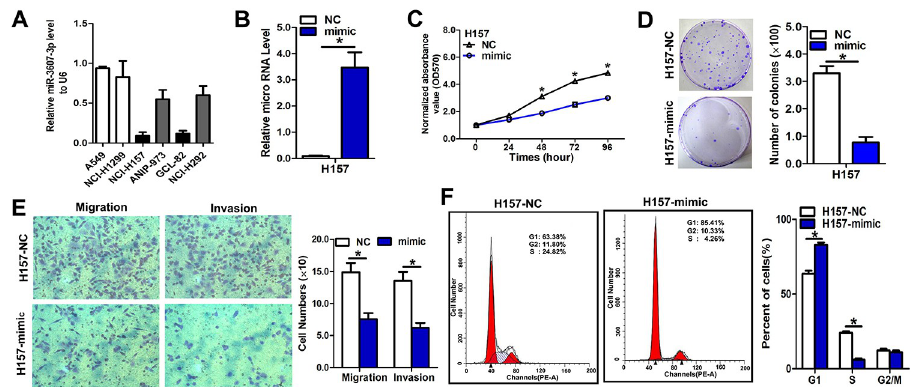
Fig 3. miR-3607-3p overexpression inhibited cell proliferation, colony formation, and migration in NSCLC cell lines. (A) RNA level of miR-3607-3p in six NSCLC cell lines. (B) Quantitation of miR-3607-3p level after the transfection of miR-3607-3p mimic (50 ng/L) in H157 cell lines. (C) Cell growth curve measured by MTS after the transfection of miR-3607-3p mimic (50 ng/L) in H157 cell lines; all OD 570 values were normalized to the starting point (0 hour). (D) Representative images and quantitative results of colony formation were obtained after transfection with miR-3607-3p mimic (50 ng/L) in H157 cell lines. (E) Representative images and quantitative results of the Transwell assay were obtained after transfection with miR-3607-3p mimic (50 ng/L) in H157 cell lines. (F) miR-3607- 3p induced cell cycle arrest at G1/S phase. Data are presented as means ± standard deviation from triplicate experiments. � , P < 0.05.